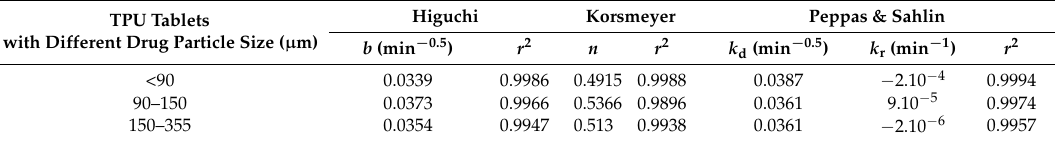
Table 1. Main kinetic parameters from TPU tablets.